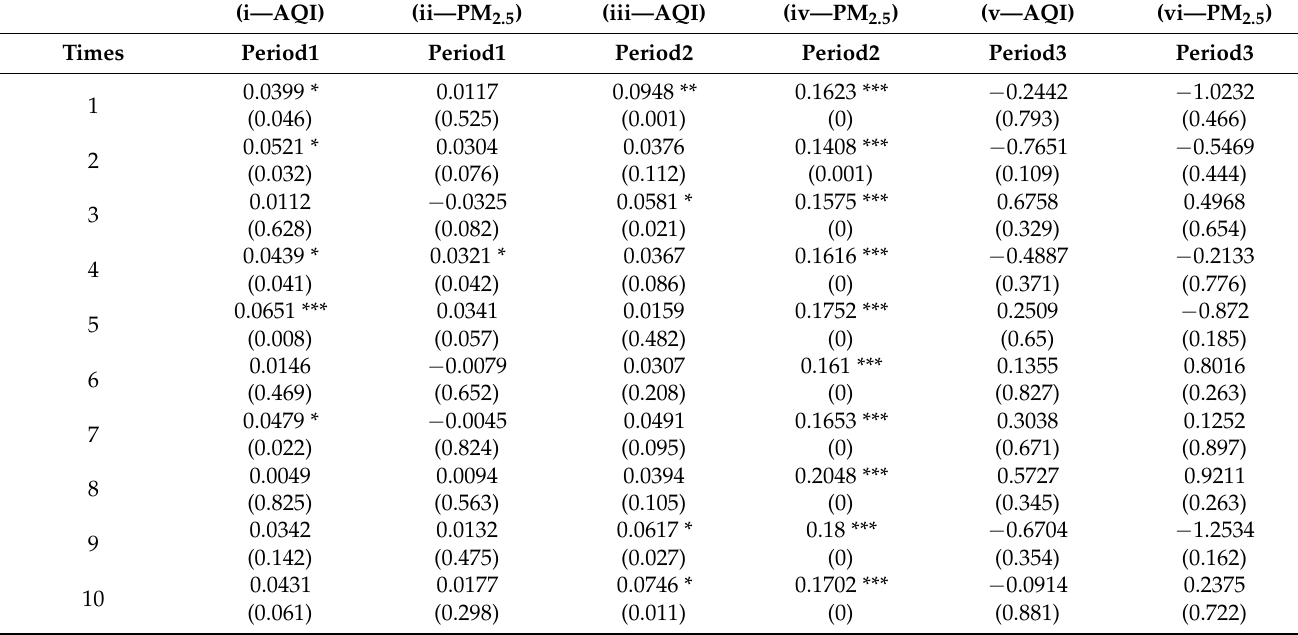
Table A11. Ten times of the effect’s estimation of air pollution on people’s activity on the randomly sampled on the subway station